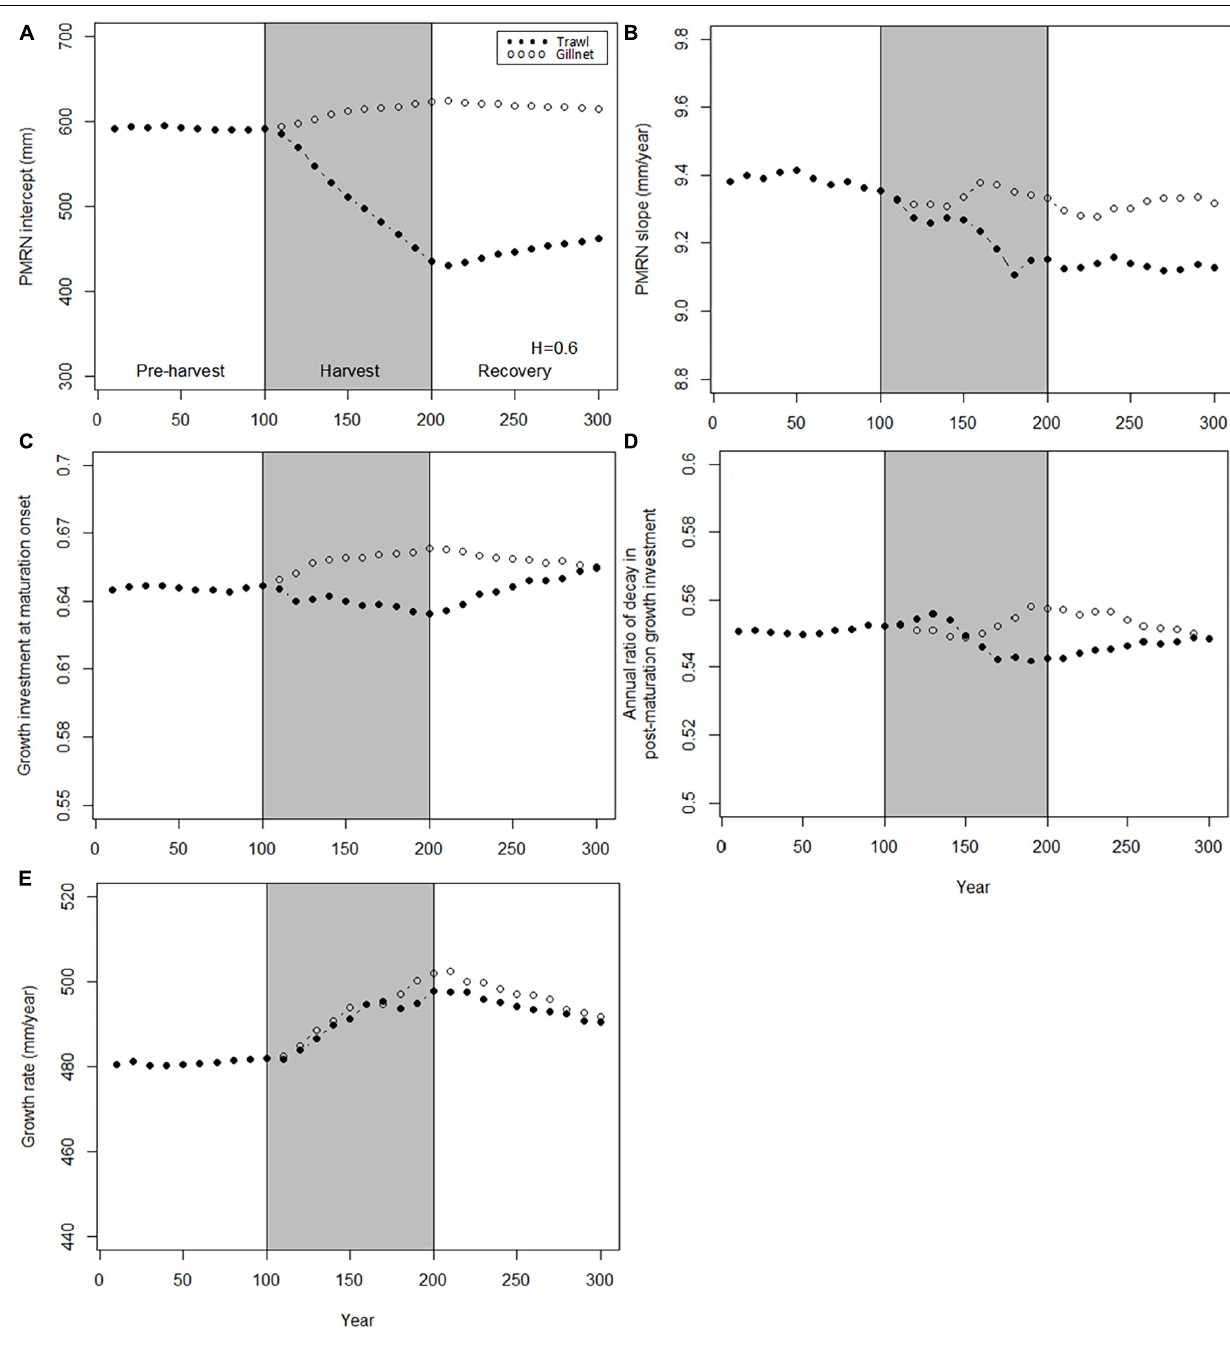
FIGURE 4 | Dynamics of the mean genotypic values of evolving traits before, during and after harvest. Harvest (gray shading) starts at t = 100 years and stop at t = 200 years. Dynamics are shown for two harvest patterns: H = 0.6 year - 1 for trawl (solid points) and H = 0.6 year - 1 for gillnet (hollow points). (A) PMRN intercept y ; (B) PMRN slope s ; (C) Growth investment α at maturation onset; (D) Annual ratio χ of decay in post-maturation growth investment; (E) Juvenile growth rate g